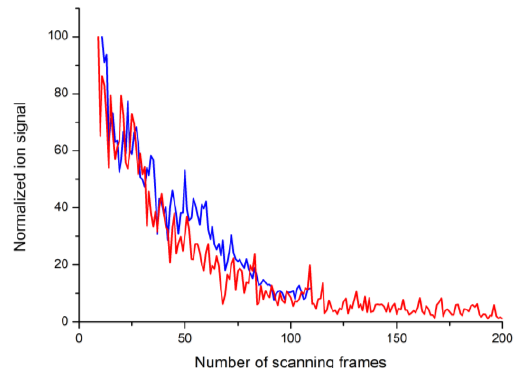
Figure 7. Evolution of the Au + ion signal under exposure to successive laser pulses vs. the number of scanning frames passed for the nanostructured gold (red) and for the surface of the silicon wafer with nanoparticles deposited via laser ablation (blue). The laser pulse energy was 1.2 μJ.